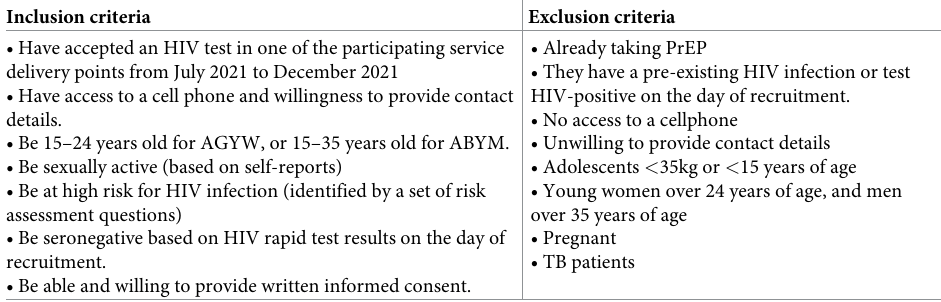
Table 1. Eligibility criteria for the SHeS’Cap-PrEP study in uMgungundlovu district, KZN, 2021. Inclusion